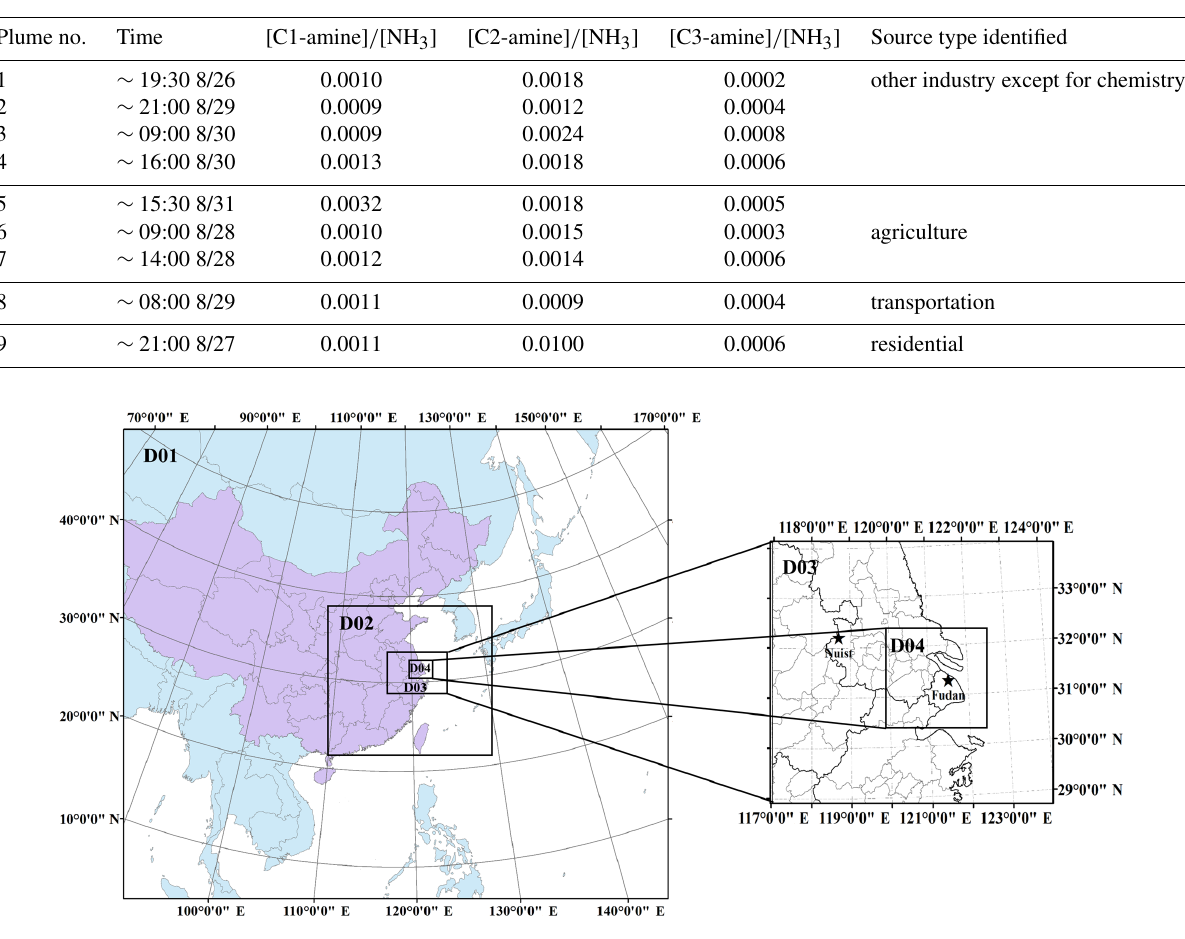
Figure 1. Four nested domains in the present study. Domain 1 covers East Asia and part of southeast Asia. Nested domains 2, 3, and 4 cover a large part of East China, the Yangtze River Delta (including Nanjing, Shanghai), and Shanghai,